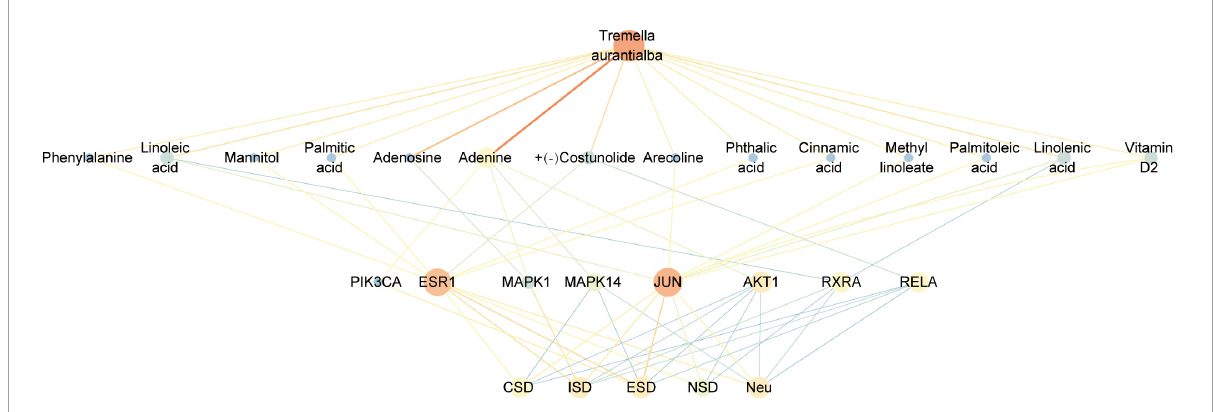
FIGURE5 Components-targets-diseases network diagram of Tremella aurantialba .